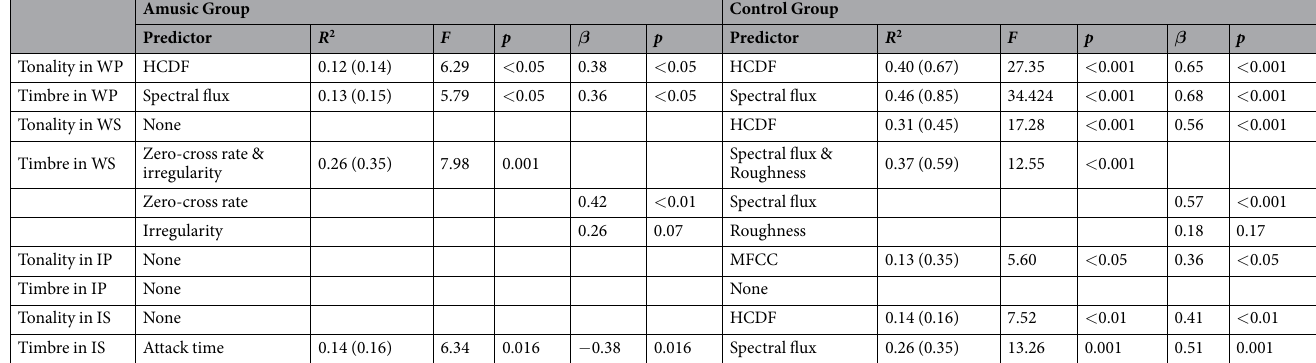
Table 1. The timbre-related and tonality-related cues that contributed significantly to tension ratings in the Western and Indian music conditions. Cohen’s f 2 , an effect size index for regression analysis, are shown